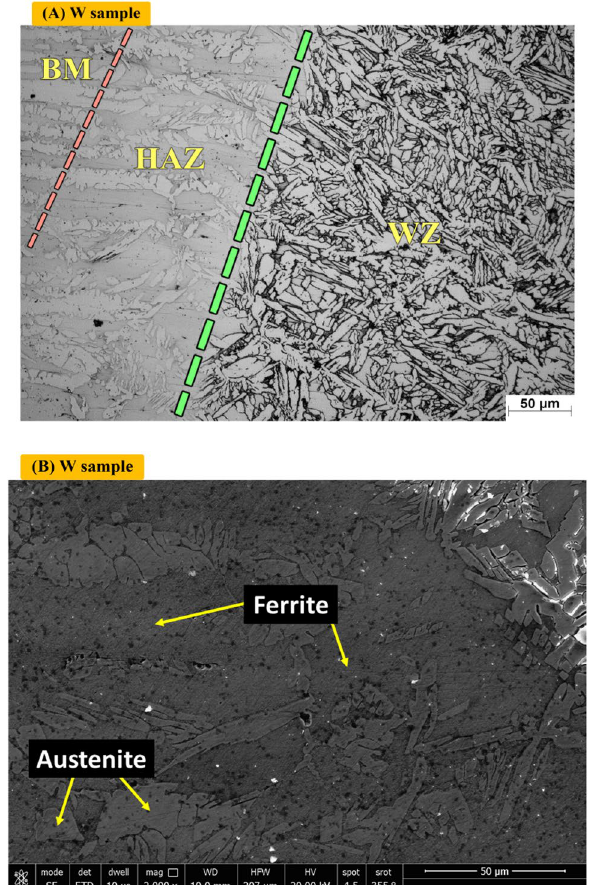
Figure 10. Optical and SEM micrographs of heat effected zone of sample (W) without PWHT